Question: What visual encoding does this figure use to show its data?
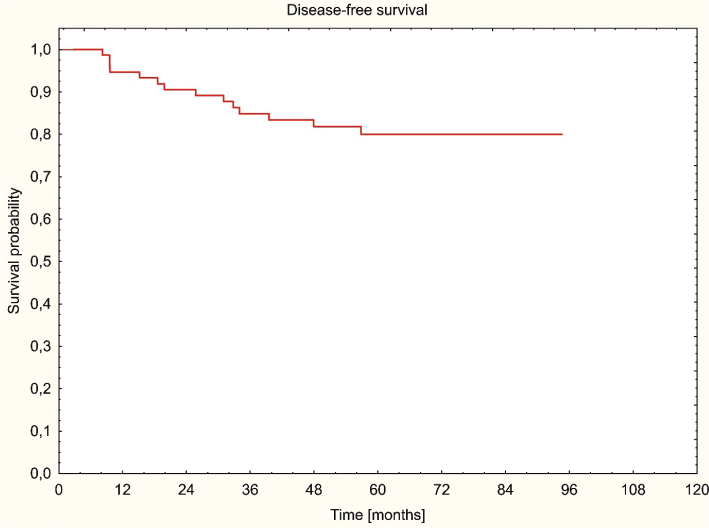
Answer: survival